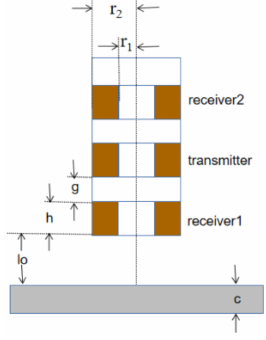
Figure 1. Sensor